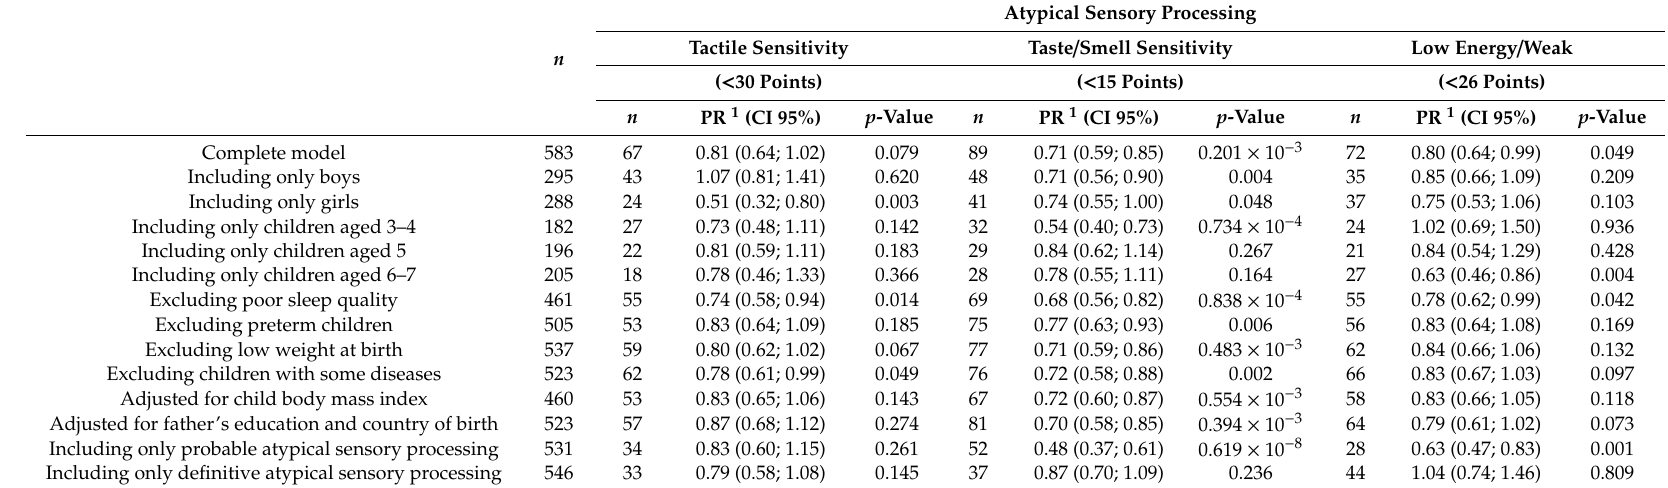
Table 4. Sensitivity analyses of the multiple-adjusted prevalence ratios for the association between two-point increase of the adherence to the MD and atypical sensory processing in the SSP tactile sensitivity, taste / smell sensitivity, and low energy and weak subscales in children aged 3–7 from InProS Project, Alicante,